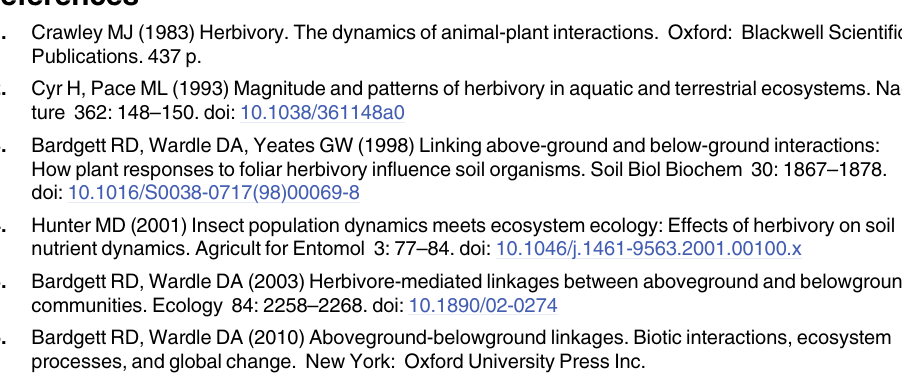
S1 Table. Identification parameters and mean (±SE) concentrations (peak area g − 1 dry lit- ter material) of secondary metabolite compounds in the insecticide treated and control Betula pendula saplings and the statistical significance of the difference between the means (n = 16, i.e. the samples were pooled within